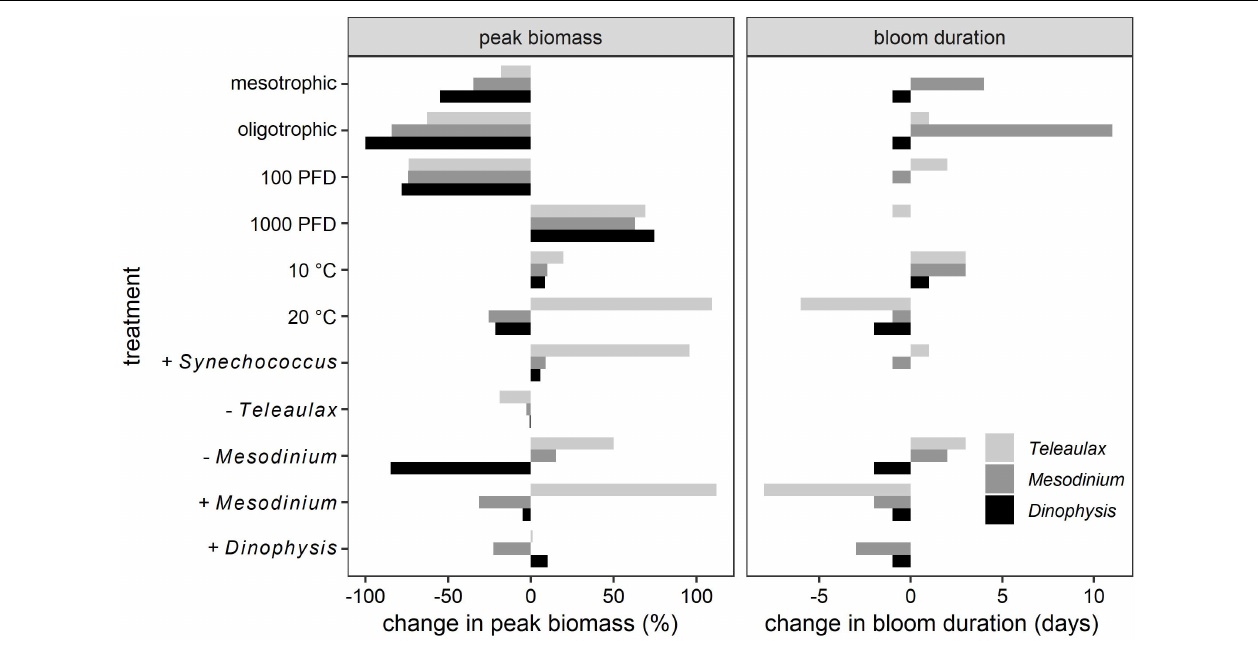
FIGURE 3 | Impact of different abiotic and biotic factors on the simulated TMD-complex bloom dynamics. Left panel, differences in peak biomass relative to the default (control). Right panel, absolute differences in bloom duration from control. “+” and “ − ” indicate an increase or decrease in the species inoculum, respectively (see also Table 4